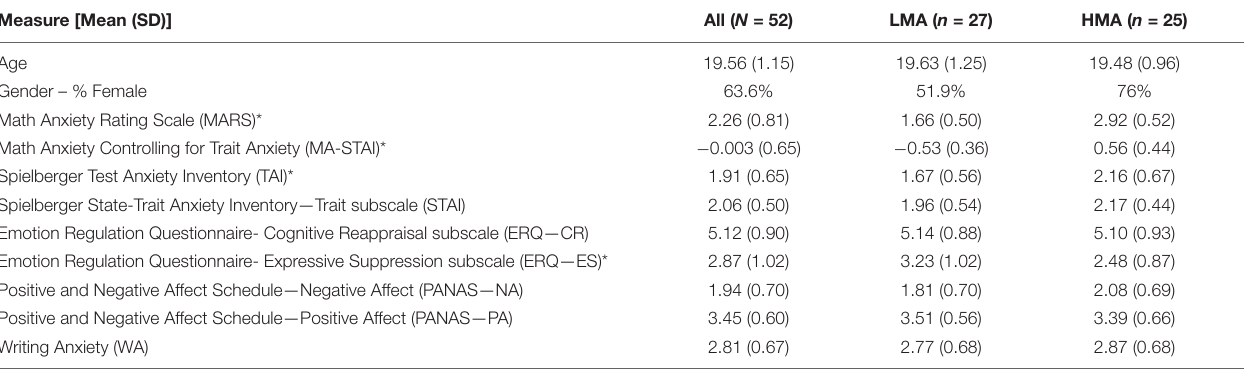
TABLE 2 | Demographic information and questionnaire